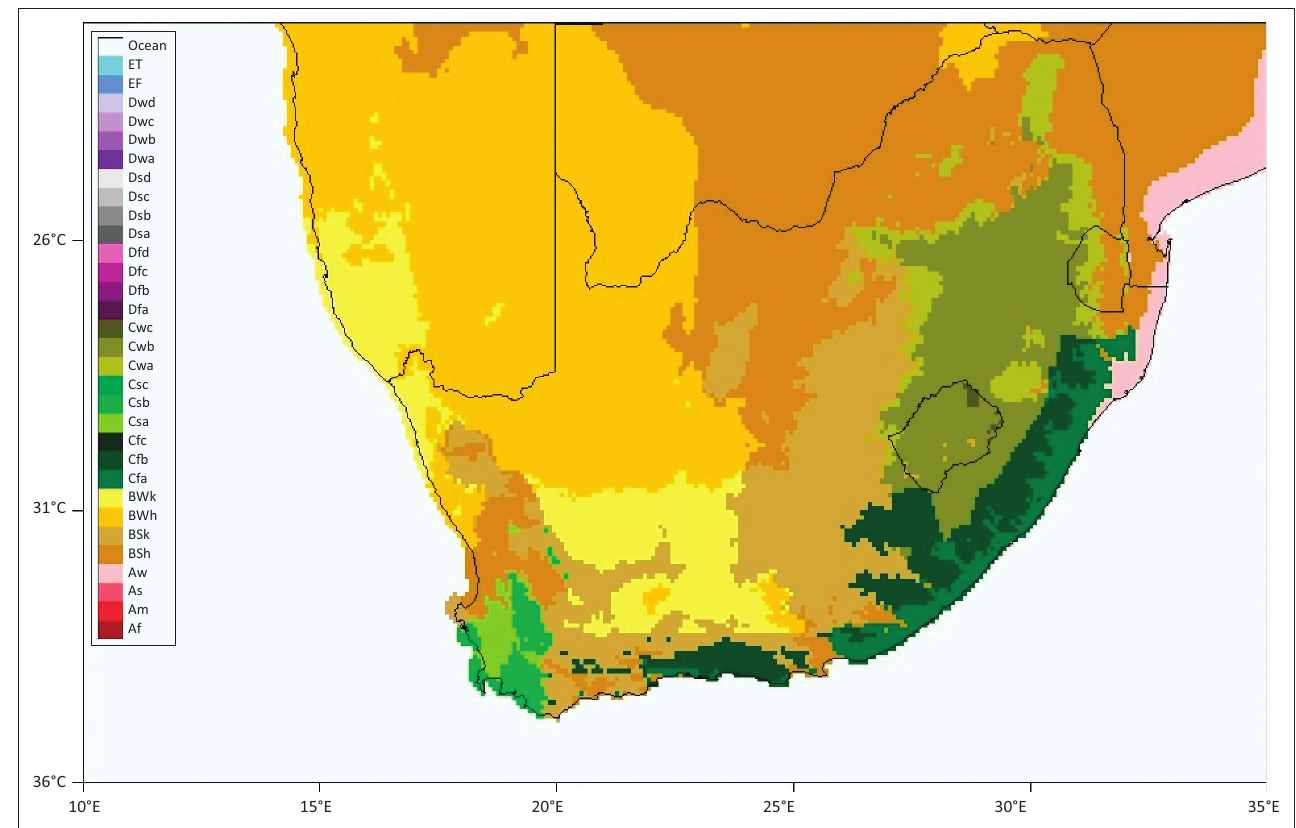
FIG URE 1: Map of South Africa with the Köppen-Geiger climate